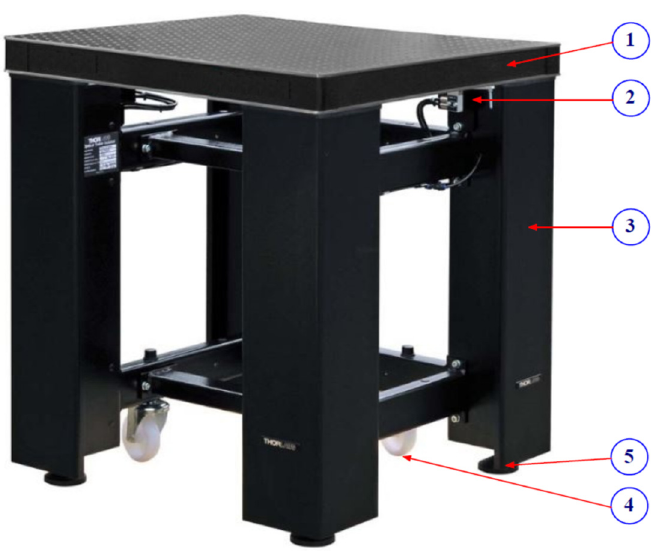
Figure 6. Anti-vibration table subsystem. Legend: 1—table work; 2—self-leveling mechanism; 3—mechanical frame; 4—movable wheels; 5—adjustable support.